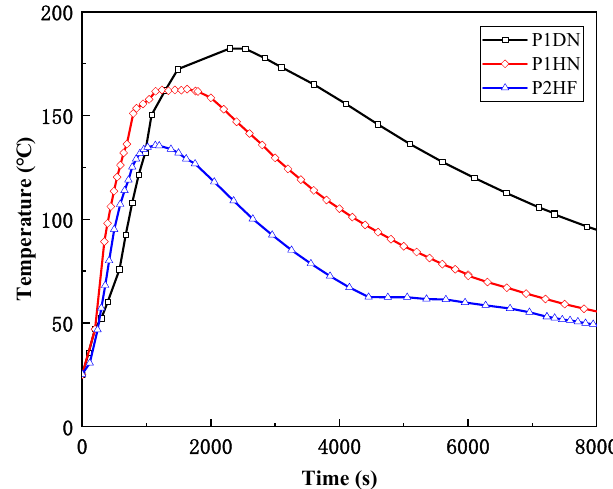
Figure 10. Temperature curve of SP2 (Figure 9) of the sand mold.